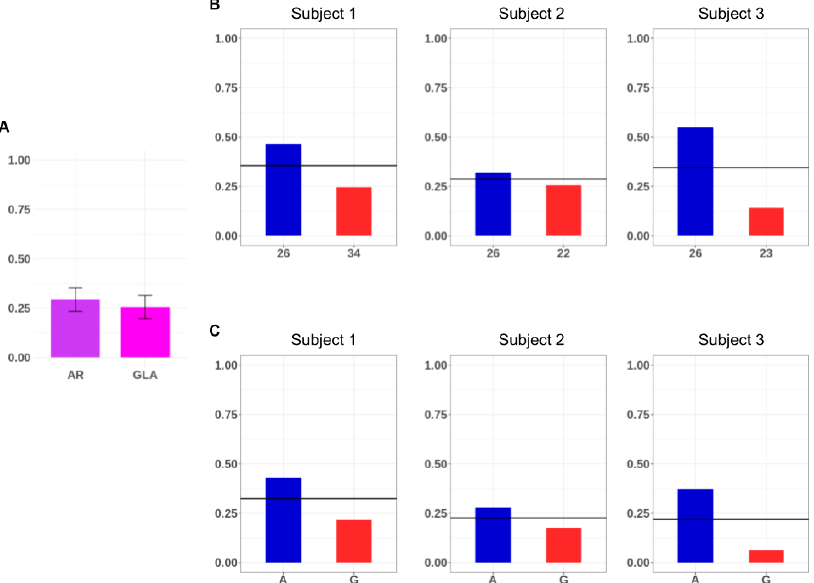
Figure 4. Locus and allele-specific average DNA methylation of the analyzed regions. ( A ) Locus average DNA methylation of the AR and GLA analyzed regions in the three selected subjects. The bars indicate the standard deviation between the subjects. ( B ) Allele-specific DNA methylation of the androgen receptor ( AR ) for the three subjects. The paternal 26 allele is colored in blue; the maternal alleles (34 for subject 1, 22 for subject 2 and 23 for subject 3) are colored in red. ( C ) Allele-specific DNA methylation of the alpha galactosidase ( GLA ) amplicon for the three subjects. The paternal shared A allele is colored in blue, while the maternal G allele in blue. In ( B ) and ( C ) the AR and GLA locus average methylation value is indicated (horizontal black line).